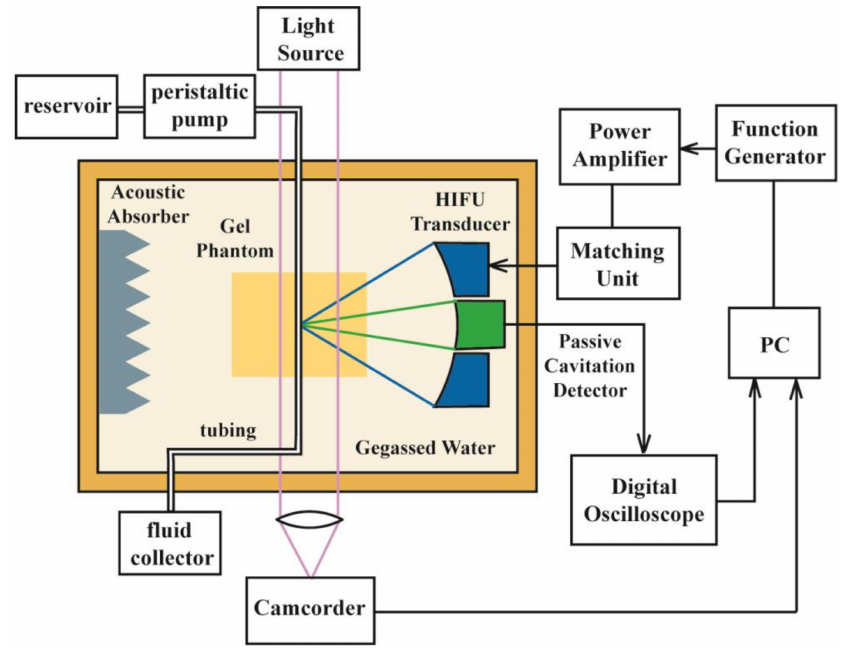
Figure 2. Schematic diagram of HIFU ablation experimental setup with the polyacrylamide gel